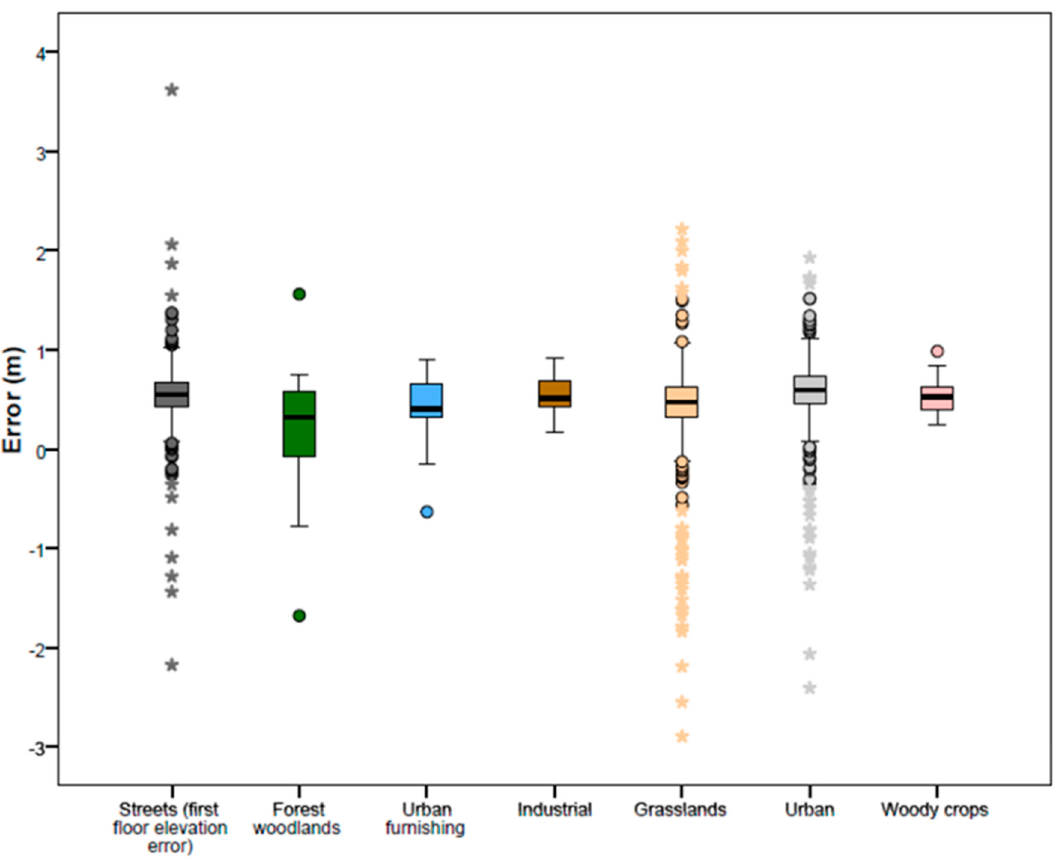
Figure 4. Box-whisker plots of elevation errors for the first floor of buildings and the different land covers present at the study site.